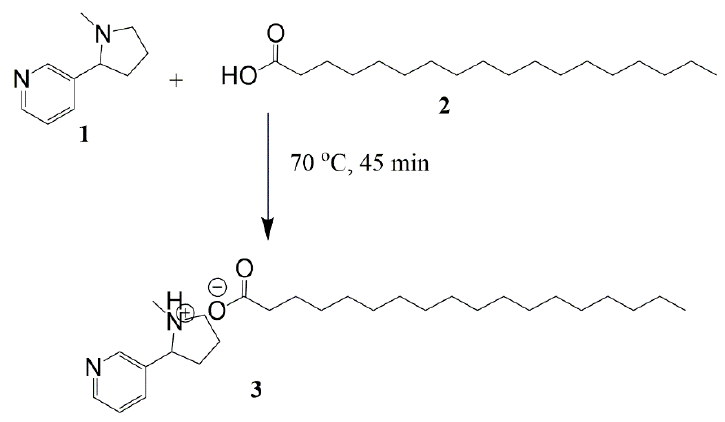
Figure 1. Synthesis of the nicotine−stearic acid conjugate.